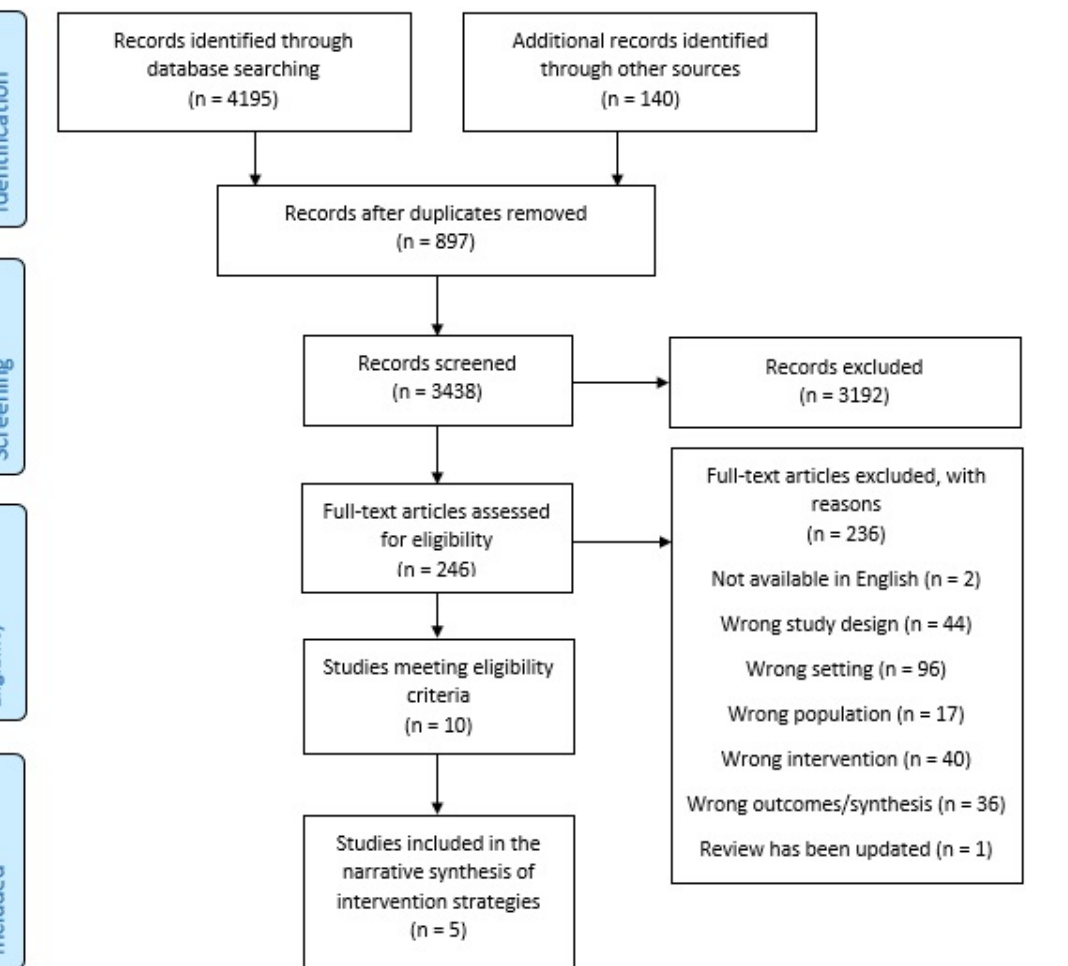
Figure 1. PRISMA flow diagram.